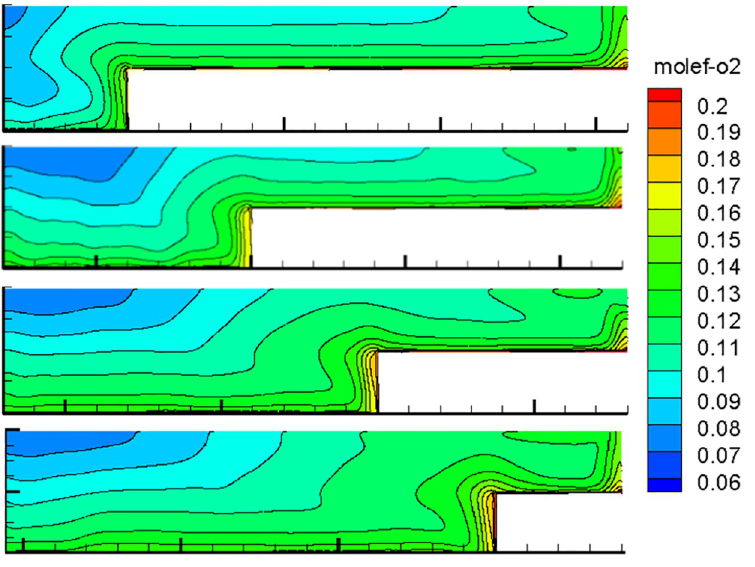
Fig 9. Flow field distribution of the oxygen volume fraction in the goaf at 5% air